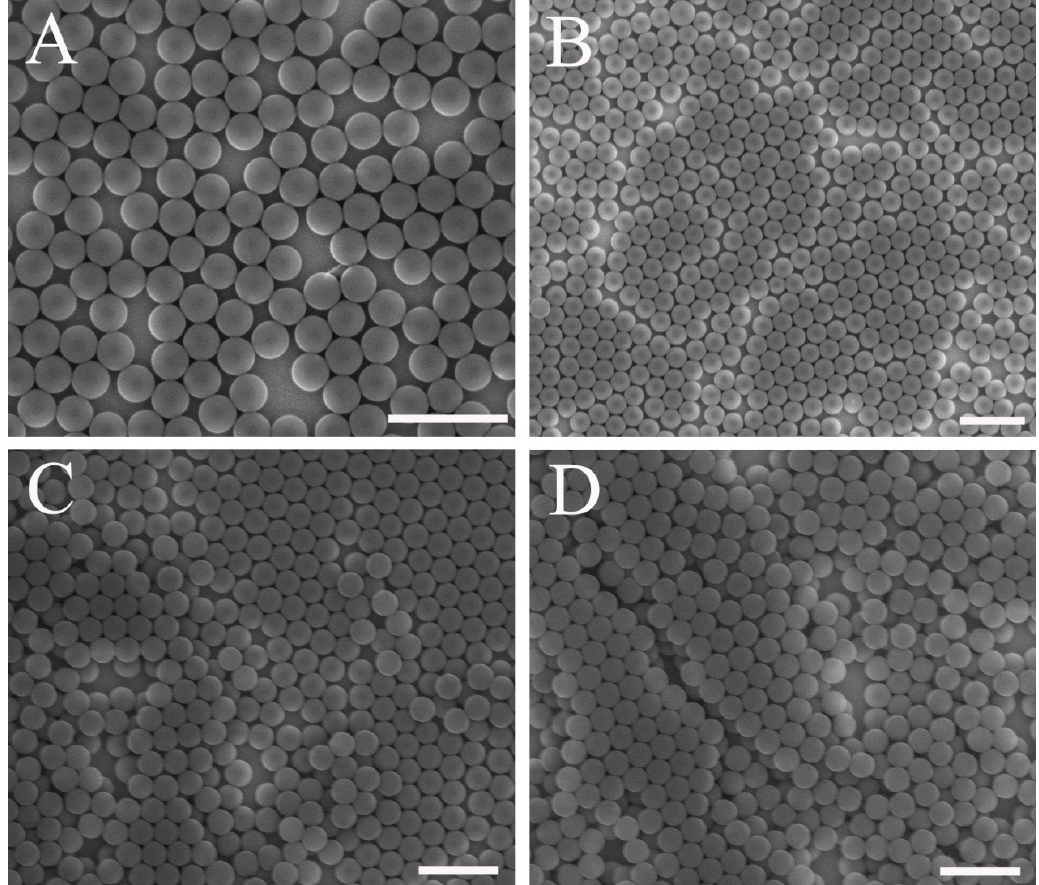
Figure 2. Colloidal crystals fabricated using PS microspheres with different concentrations. ( A ) 1 wt. %; ( B ) 2 wt. %; ( C ) 5 wt. %; ( D ) 10 wt. %. (Scale bar 1 µ m. All colloidal crystals were already